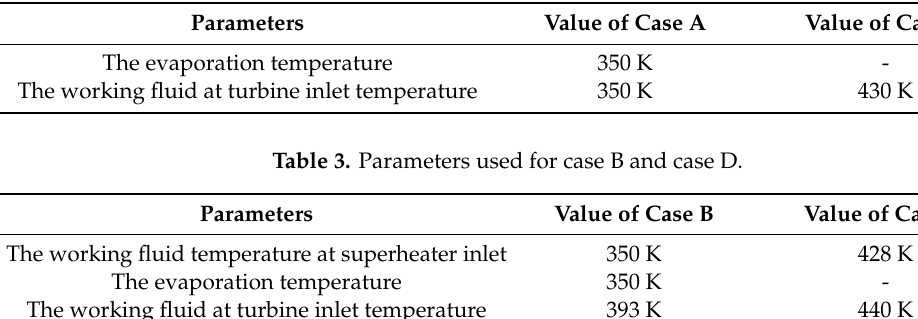
Table 2. Parameters used for case A and case C.